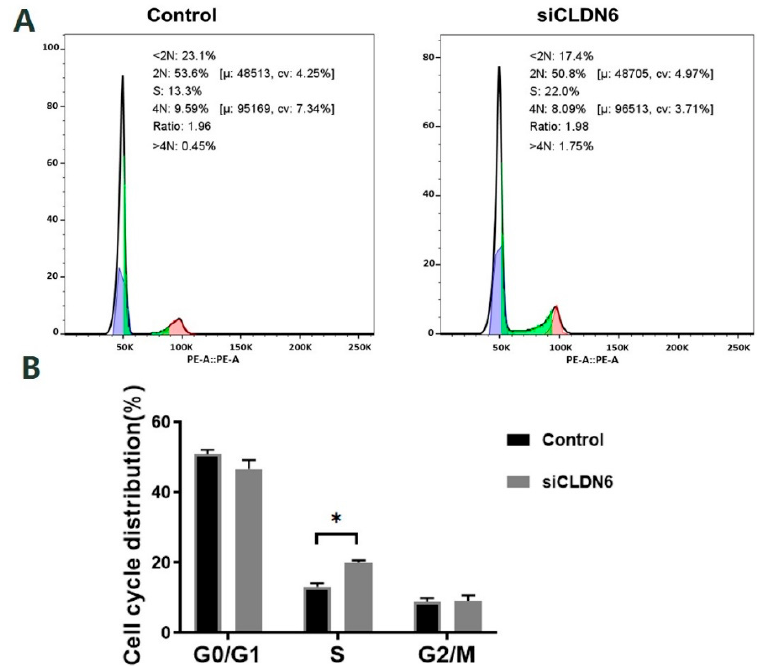
Figure 6. Cell cycle of bovine CCs with CLDN6 knockdown. ( A ) After transfected with siCLDN6